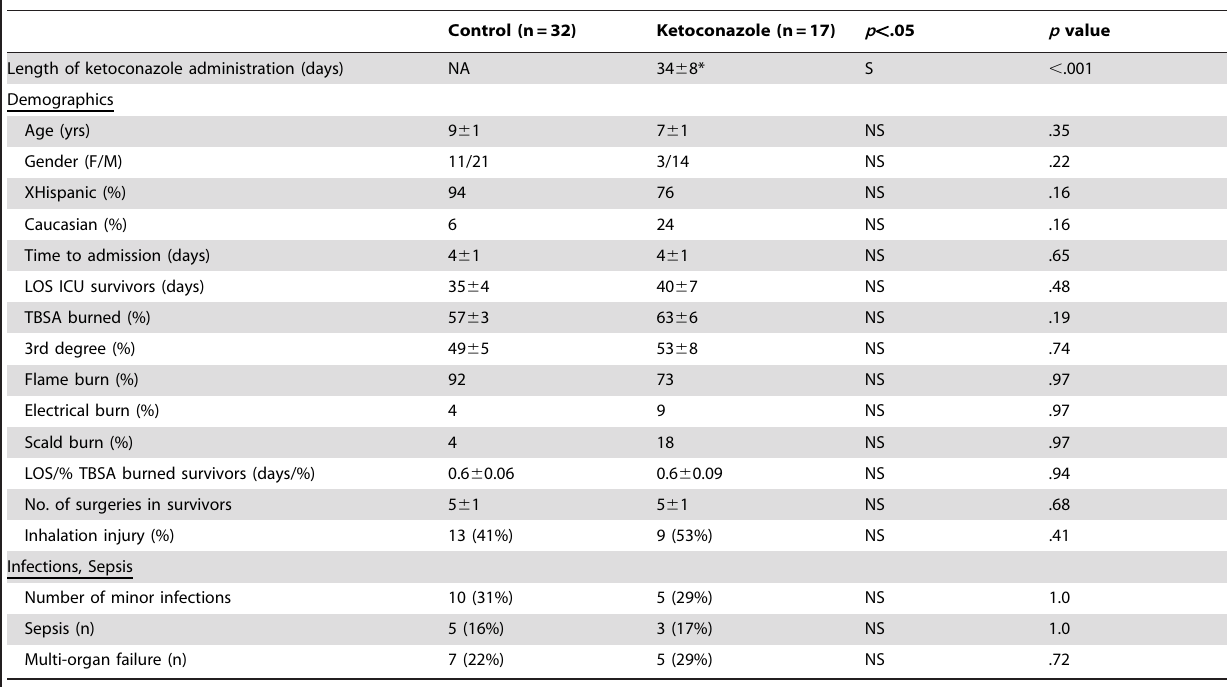
Table 1. Patient demographics and the effect of ketoconazole.